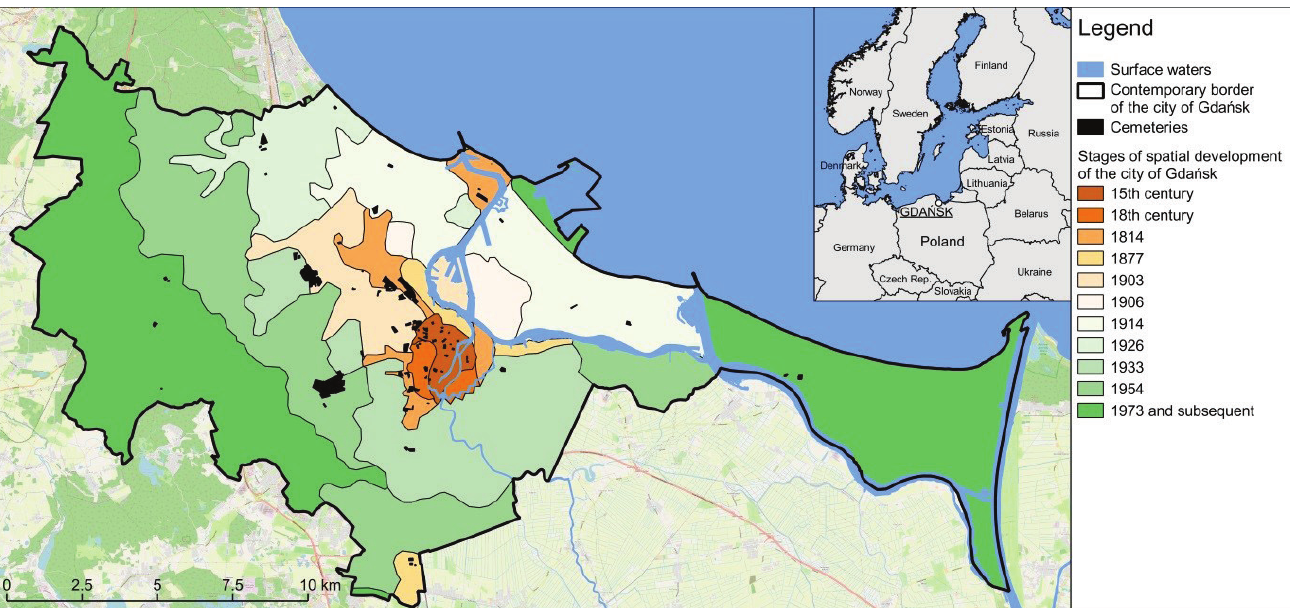
Figure 3. Spatial development of Gdańsk and location of cemeteries within the city historical and contemporary boundaries. Source: Own elaboration based on Labenz (1999), changed.